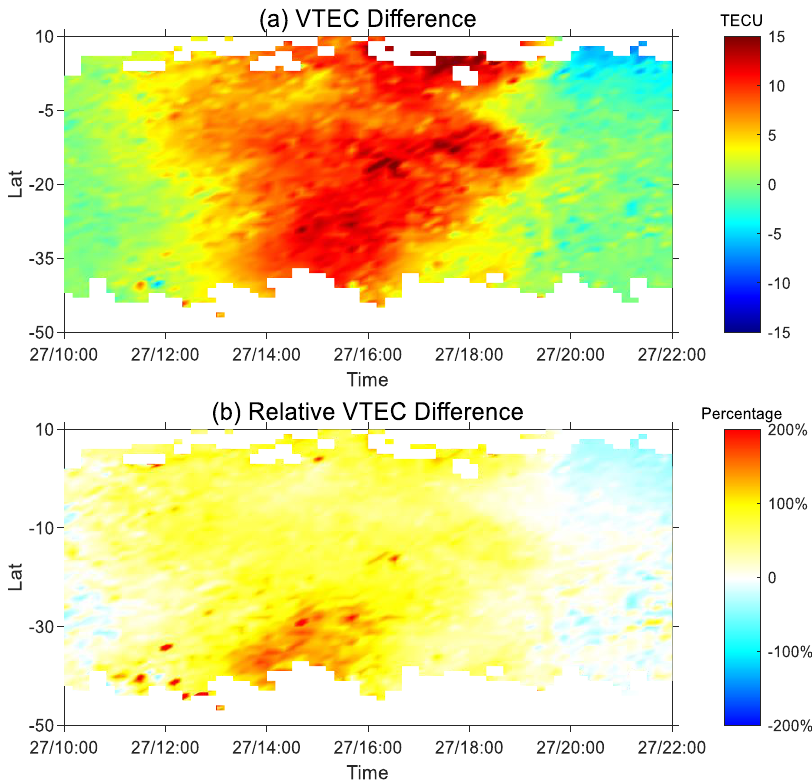
Figure 10. Latitude/time variation of ( a ) VTEC difference and ( b ) relative VTEC difference of storm-4 from 10°N to 50°S at 50°W.